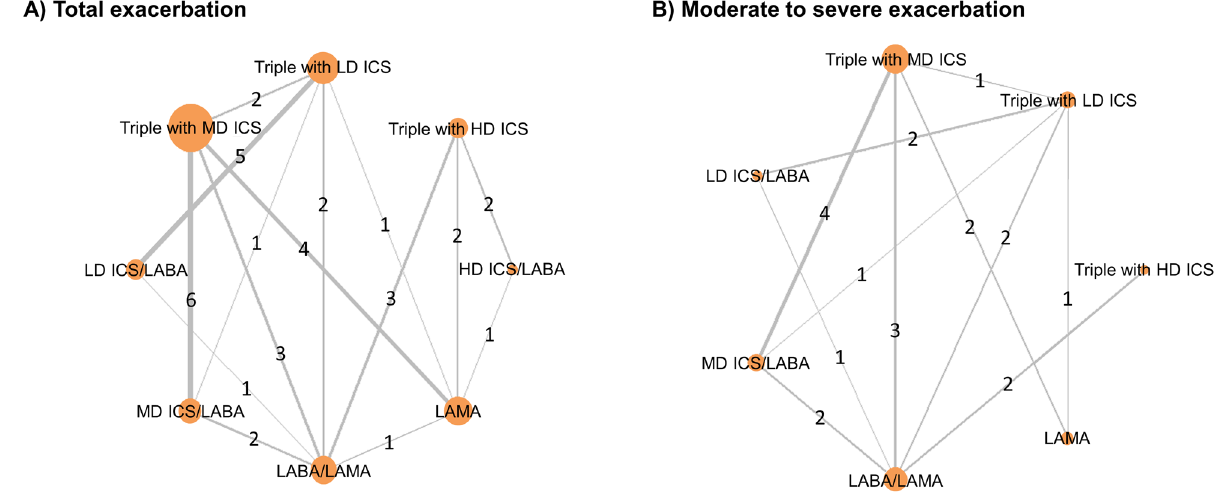
Figure 2. Network geometry of the 26 eligible randomized controlled